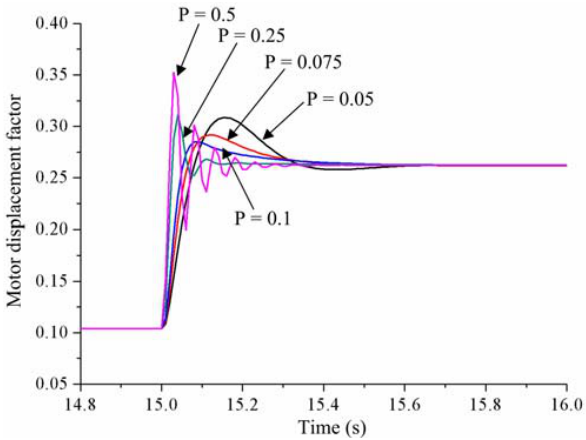
Figure 5. Simulated motor displacement responses of the HESGS with different proportional gains.